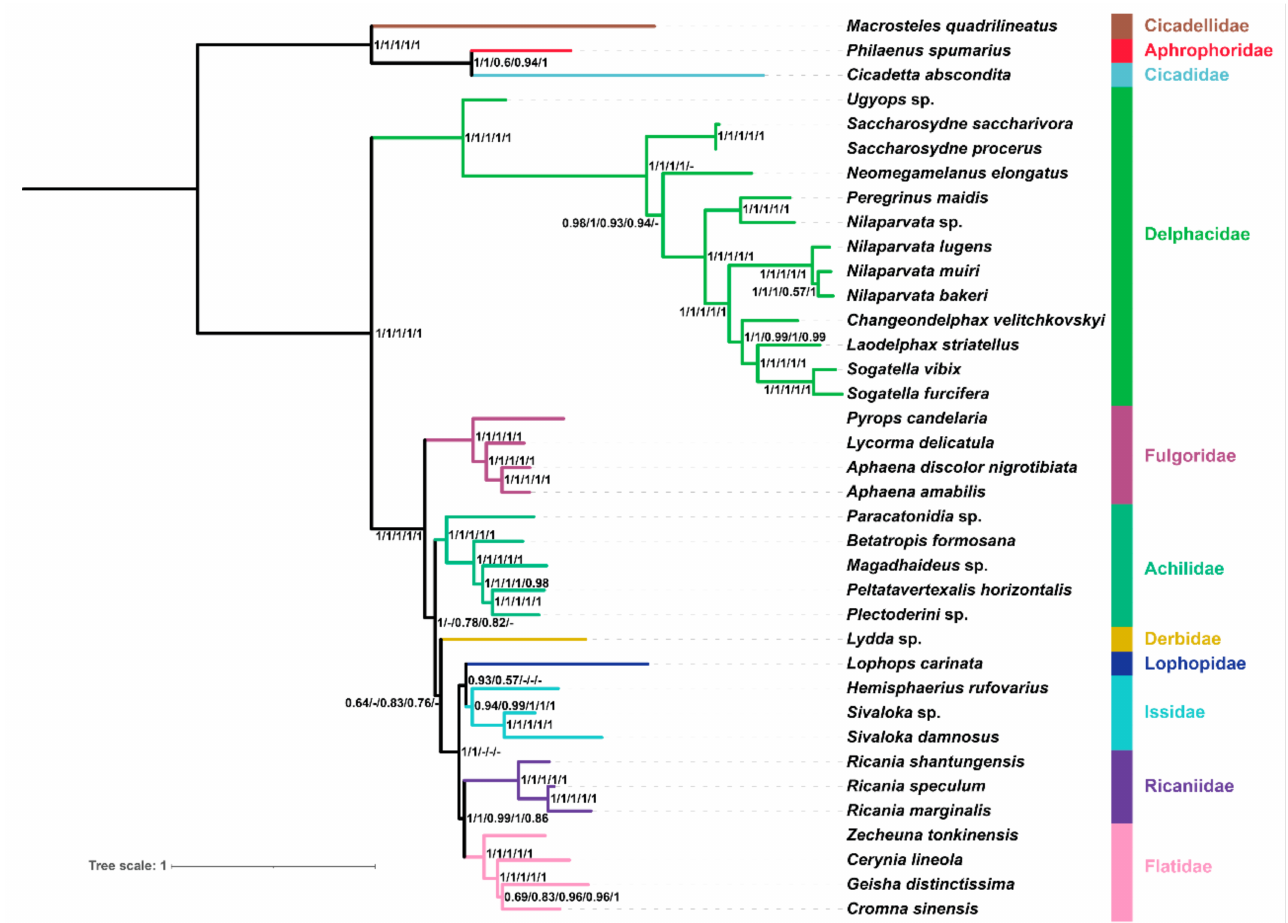
Figure 8. Phylogenetic tree inferred from PhyloBayes based on the datasets of PCG, PCGRNA, PCG12, PCG12RNA, and AA. Supports at nodes (from left to right) are Bayesian posterior probabilities (PP) for PCG, PCGRNA, PCG12, PCG12RNA, and AA. “-” indicates the clades are